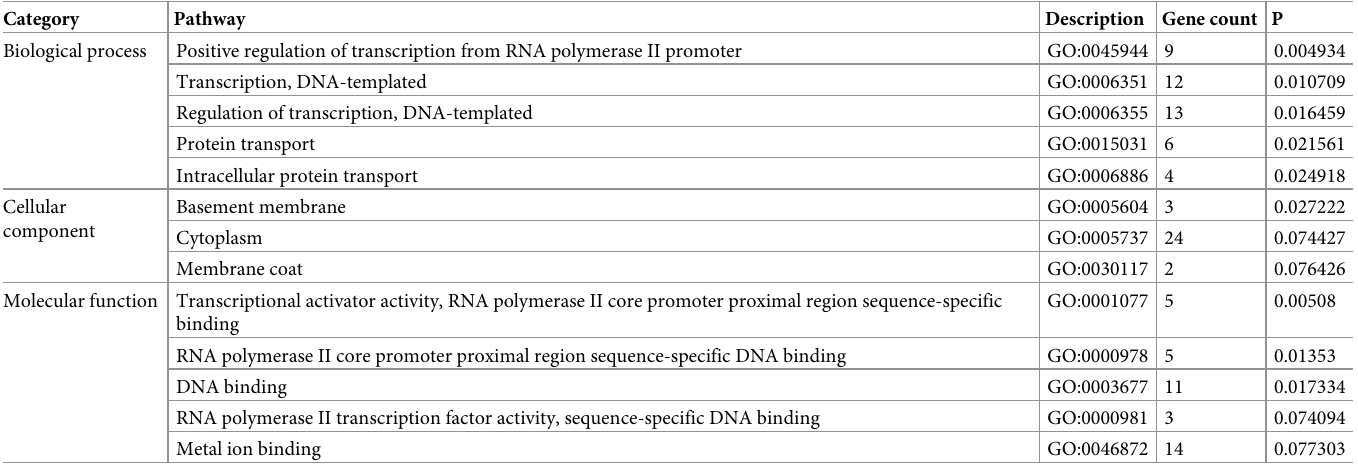
Table 4. The significantly enriched pathways associated with 58 mRNAs in the N.g MDP–treated osteocyte